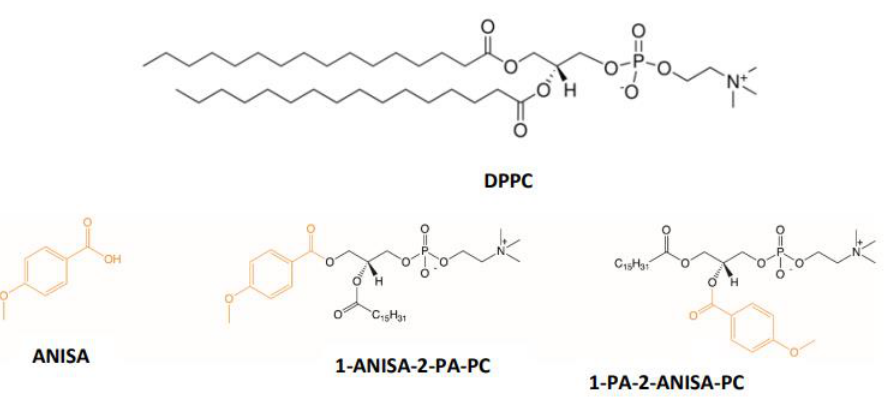
Figure 1. Structures of investigated p -anisic acid (ANISA) and its bioconjugates with phosphatidyl- choline: 1-anisoyl-2-palmitoyl- sn -glycero-3-phosphocholine (1-ANISA-2-PA-PC) and 1-palmitoyl-2- anisoyl- sn -glycero-3-phosphocholine (1-PA-2-ANISA-PC) and